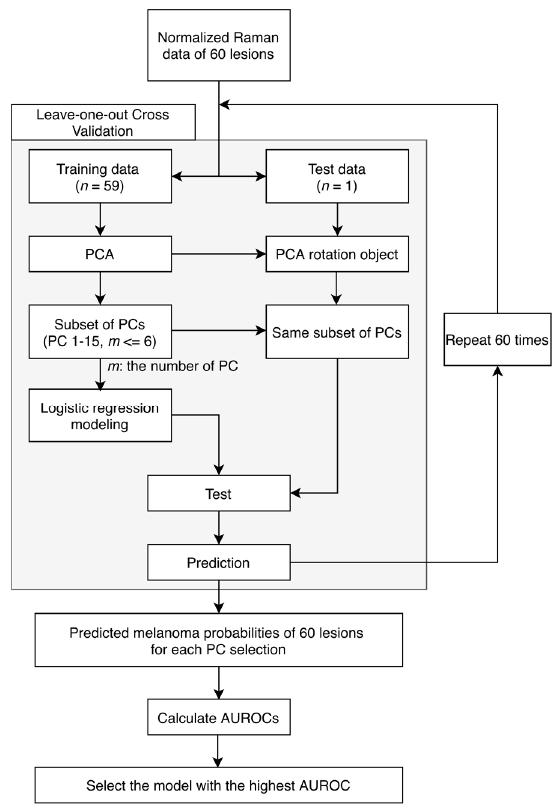
Figure 3. Data analysis pipeline. Principal component analysis (PCA) and logistic regression model with leave one lesion out cross validation are applied to classify melanoma and pigmented lesions based on normalized Raman spectral data. AUROC shows the classification accuracy.